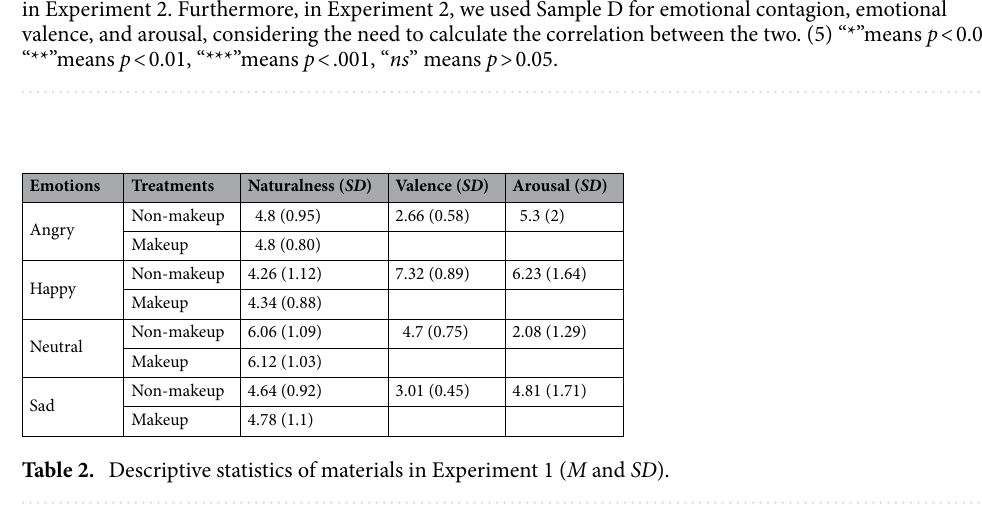
applications in real life, such as skin whitening 43 and smoothing 44 . The edited pictures were then recomposed both the original and makeup versions may look unnatural. To confirm that both versions matched in terms of how natural they looked and the extent to which makeup enhanced facial attractiveness, another 23 partici- pants (Sample B, nine males, M = 19.78 ± 1.88 years old) were asked to rate how natural all the video clips were and how attractive the models were in all neutral video clips—this was done using a nine-point Likert scale,